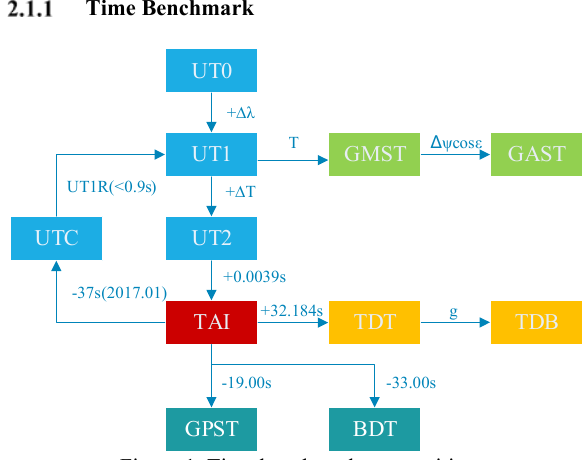
Figure 1. Time benchmark composition